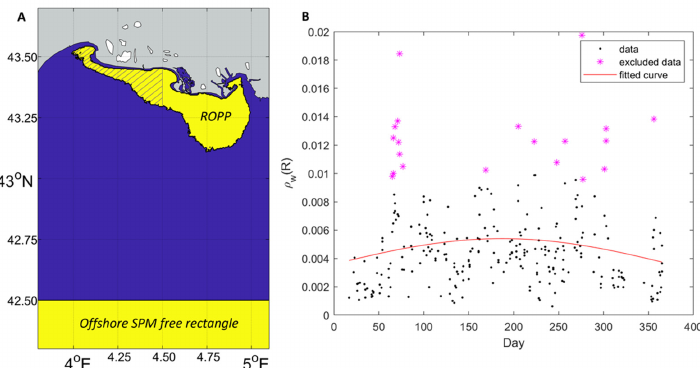
Figure A1. ( A ) Delimitation of the region of plume presence (ROPP) and the offshore SPM free rectangle used in MODIS dataset filtering. ( B ) Mean offshore water-leaving reflectances in the MODIS red band obtained in the offshore SPM free rectangle ( A ) for all cloud-free MODIS images in the year 2014. The ρ w (R) values are plotted as a function of days and modeled with a Gaussian curve. MODIS images with differences between the offshore reflectances and the modeled reflectances larger than 1.5 times the standard deviation of the offshore reflectances were considered outliers and excluded from the